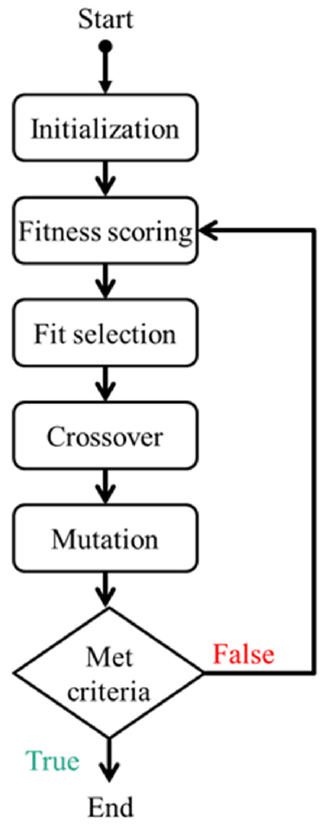
Figure 3. Six step flow diagram of the genetic algorithm.